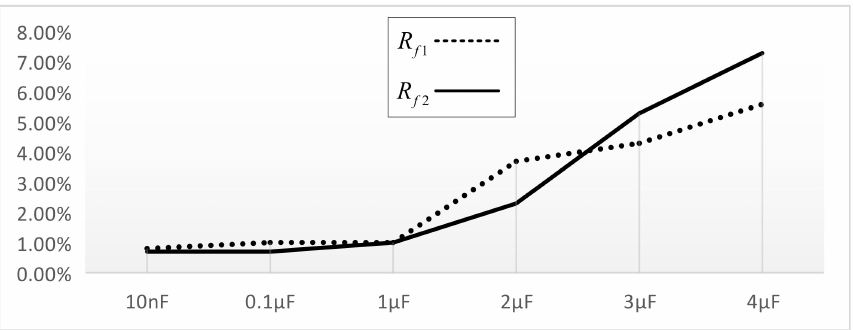
Figure 11. RE% with di ff erent sampling intervals.